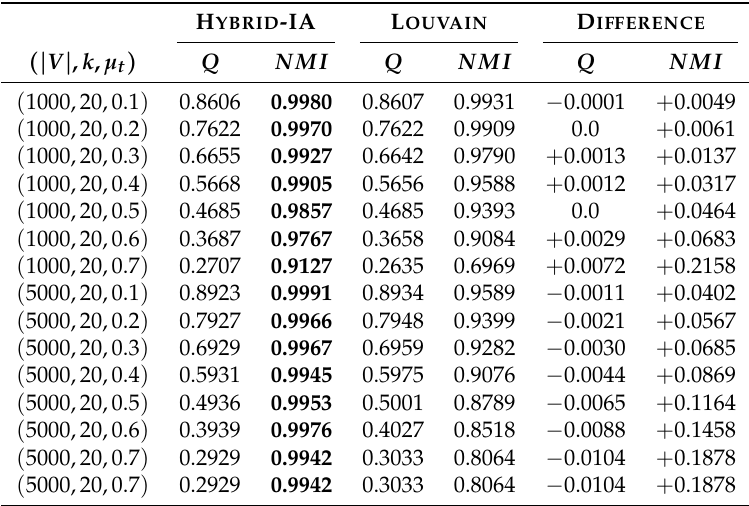
Table 3. Comparison between H YBRID -IA and L OUVAIN on Synthetic Networks with 1000 and 5000 vertices, with respect to modularity ( Q ) and NMI evaluation